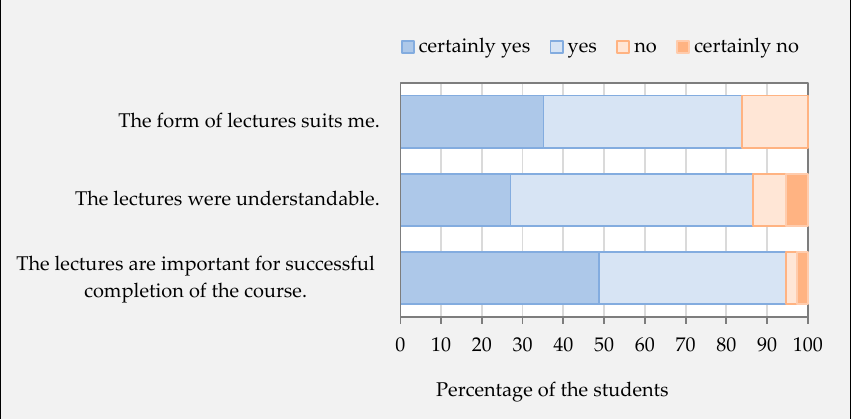
Figure 13. The students’ evaluation of completed lectures.